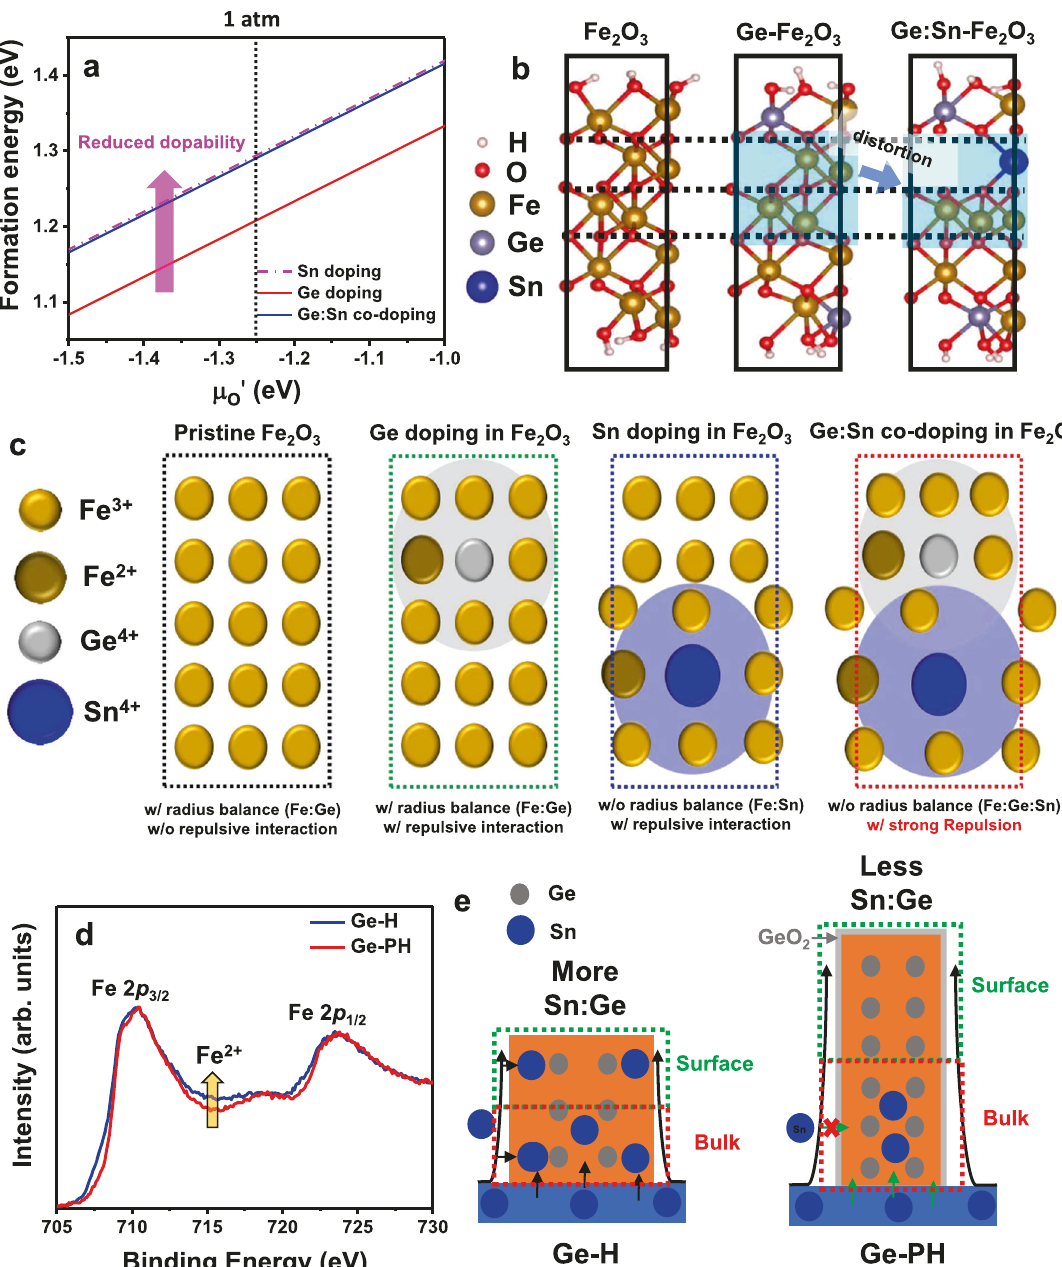
Fig. 3 DFT calculations and experimental results for Ge and Sn interaction. a The formation energy for Sn-doping, Ge-doping, and Ge:Sn co-doping in Fe 2 O 3 . The dotted line represents 1 atm at which the experiments were performed. b DFT calculations of atomic arrangements of Fe 2 O 3 with different dopant environments. c Atomic structure of Ge-doped Fe 2 O 3 Sn-doped Fe 2 O 3 and Ge:Sn co-doped Fe 2 O 3 . d XPS spectra of Fe 2 p . e Schematics of the distribution of Sn and Ge according to co-doping